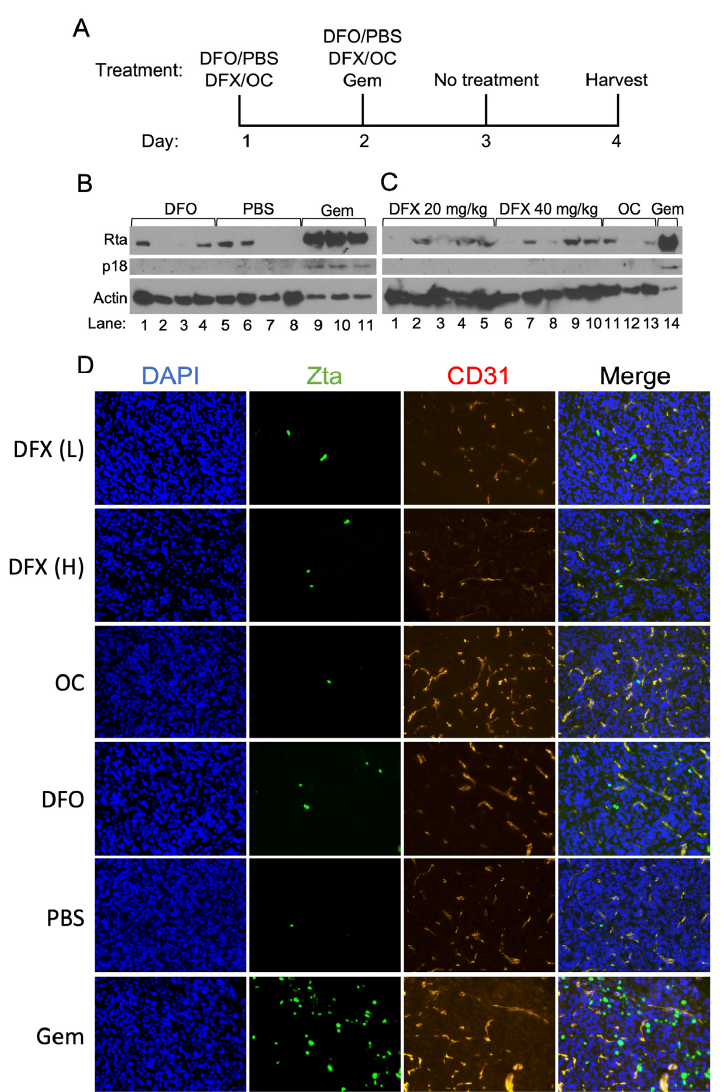
Figure 7. Effects of DFO and DFX treatment of AGS-Akata xenografts grown in immuno-suppressed mice. 1 × 10 7 AGS-Akata cells were injected into the left flank of NSG mice. When the xenografts reached ~150 mm 3 in size, the mice were treated as described in ( A ) with DFO, a low (L, 20 mg/kg) or high (H, 40 mg/kg) dose of DFX, gemcitabine, PBS, or the DFX vehicle (OC). The tumors were harvested two days after the last treatment. ( B , C ) Half of each tumor was homogenized and processed by immunoblot analysis for Rta, p18/VCA, and actin as a loading control. For gemcitabine-treated tumor samples, 8-fold less extract was loaded into the gel. ( D ) The other half of each tumor was flash-frozen, 10 μ m sections taken, and stained for Zta (green), the blood vessel marker CD31 (red), and DAPI (blue) to detect nuclear DNA. Shown here are representative data photographed at 20X magnification from 3 separate experiments performed with DFO and 1 with DFX.